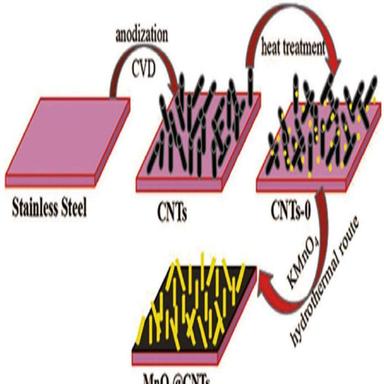
Graphical representation of the core–shell MnO2 at CNTs composite electrode prepared on a stainless steel substrate. Reproduced from Ref.. .